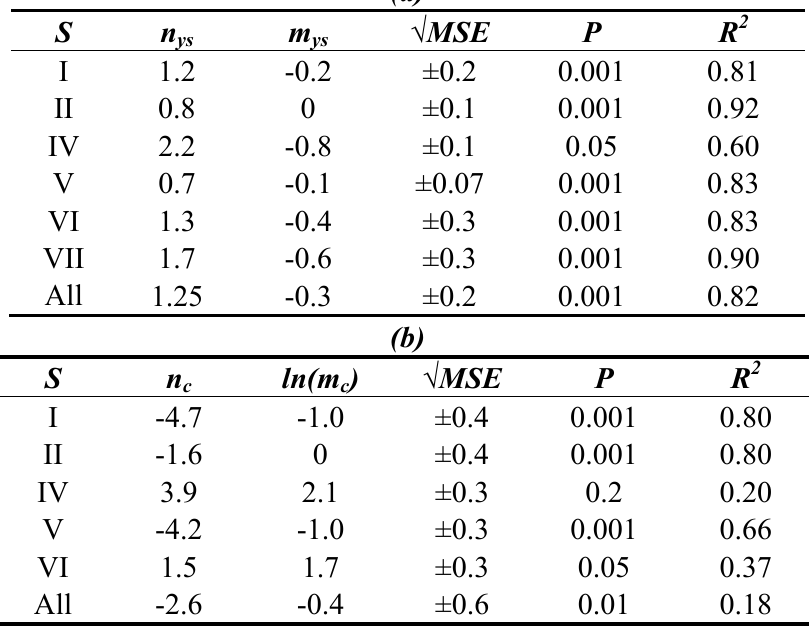
Table 3. Reduced major axis regression results, using Galway Bay survey ( S ) data, for